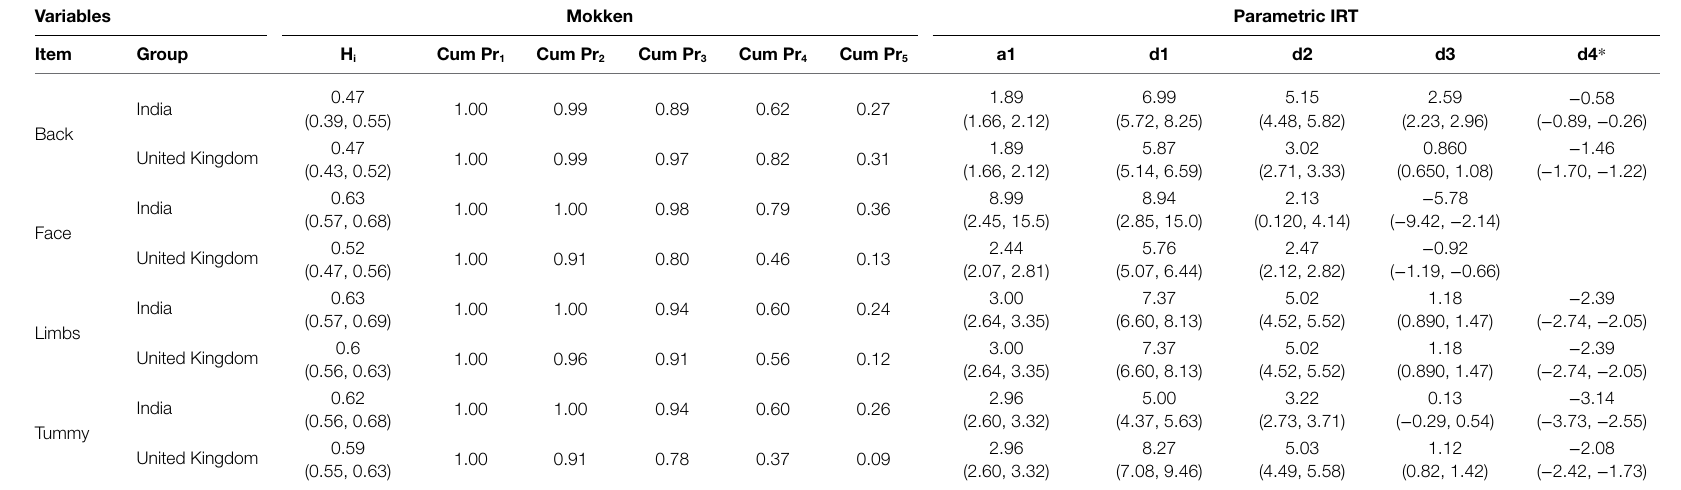
TABLE 4 | India-UK comparison between non-parametric (Mokken scaling) and parametric (IRT) DIF for the stroking dimension including: non-parametric scalability coefficients H i (and 95% CI), cumulative probability of responses ( Cum Pr), and parametric estimates with 95% CI of slope (a1) and intercept coefficients (d1–d4) for the IRT Graded Response Model (GRM). Variables Mokken